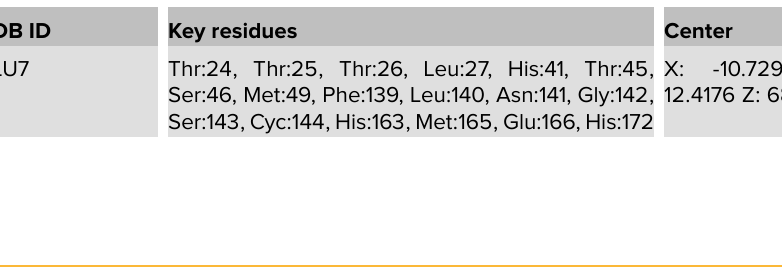
Table 1: Grid selection and targeted key residue.